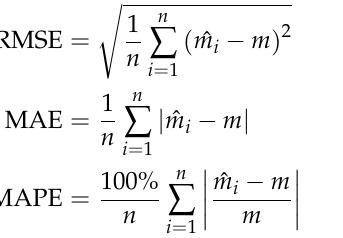
test conditions. Figure 6. Slopes of simulation test ::: :::::::::